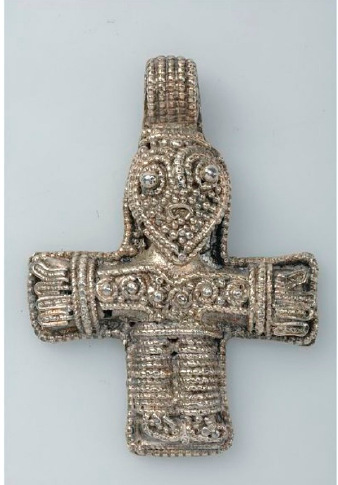
Figure 7. Crucifix from Birka. Silver pendant, 9th century. Stockholm, SHM, Inv. No. 34 000. Photo: Gabriel Hildebrand (CC BY 2.5. SE).